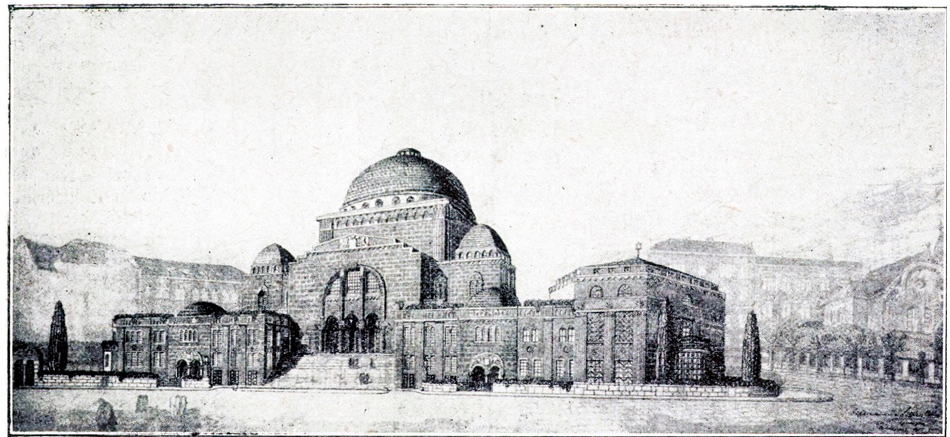
Figure 7. Perspective view—mass division and building arrangement as the “fundamental idea” (Sándor and Béla Löffler, 1914). Source: Épít ő Ipar – Épít ő M ű vészet , 22 March 1914, p. 117.